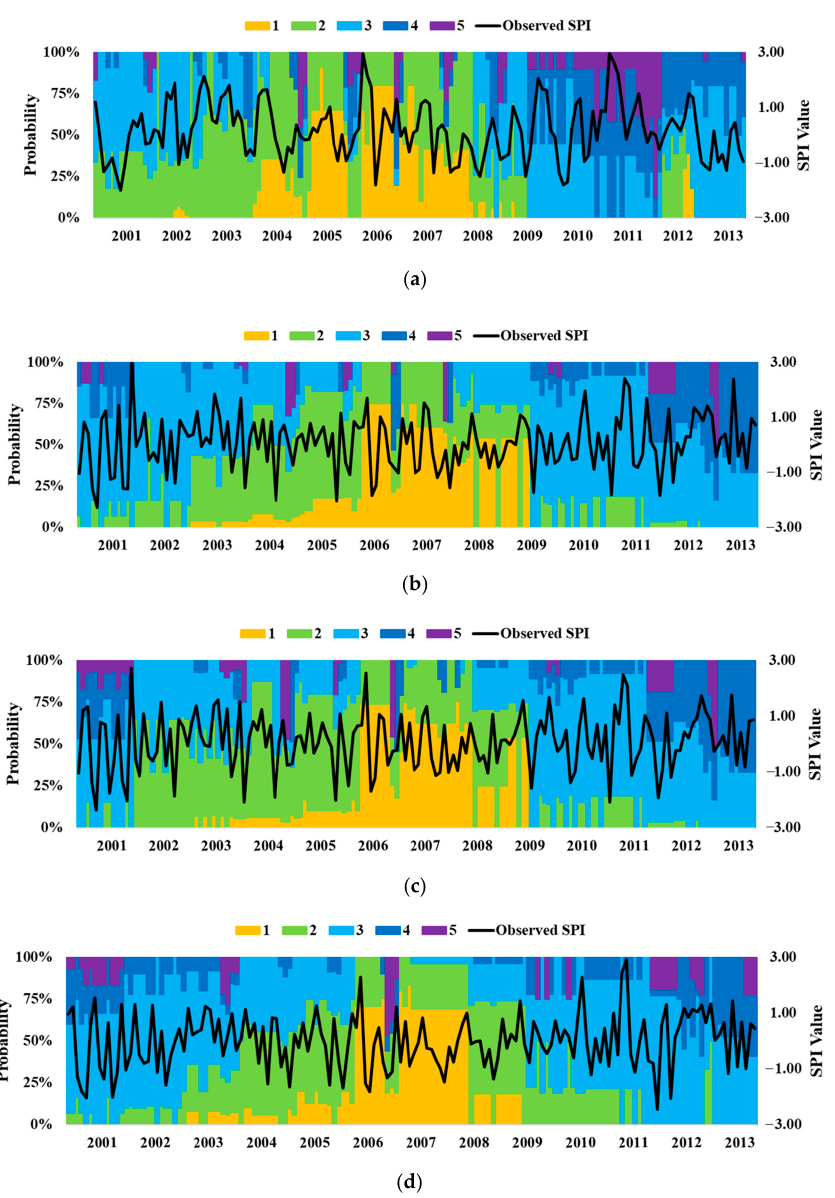
Figure 5. Probabilistic distribution of the different classes of meteorological drought assessed through MBC during 2001–2013 and compared with the observed SPI. ( a ) Sub-basin #1003, ( b ) Sub-basin #1010, ( c ) Sub-basin #1012, ( d ) Sub-basin #1018.